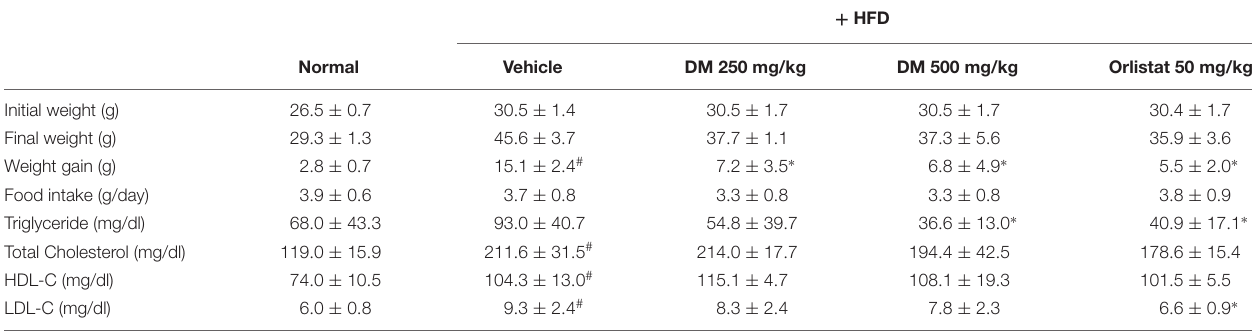
TABLE 1 | The changes of body weight, food intake, and serum profiles.